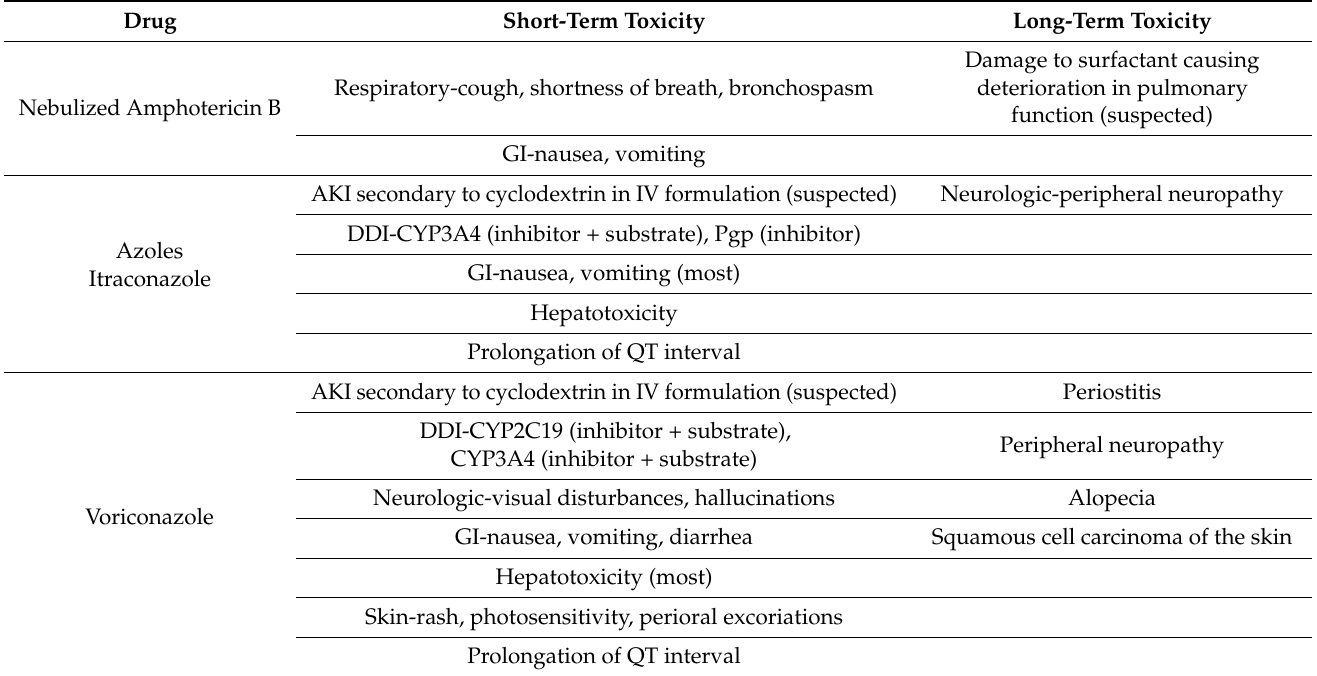
Table 2. Toxicities of antifungals used for prophylaxis and preemptive treatment. Drug Short-Term Toxicity Long-Term Toxicity Respiratory-cough, shortness of breath, bronchospasm Nebulized Amphotericin B